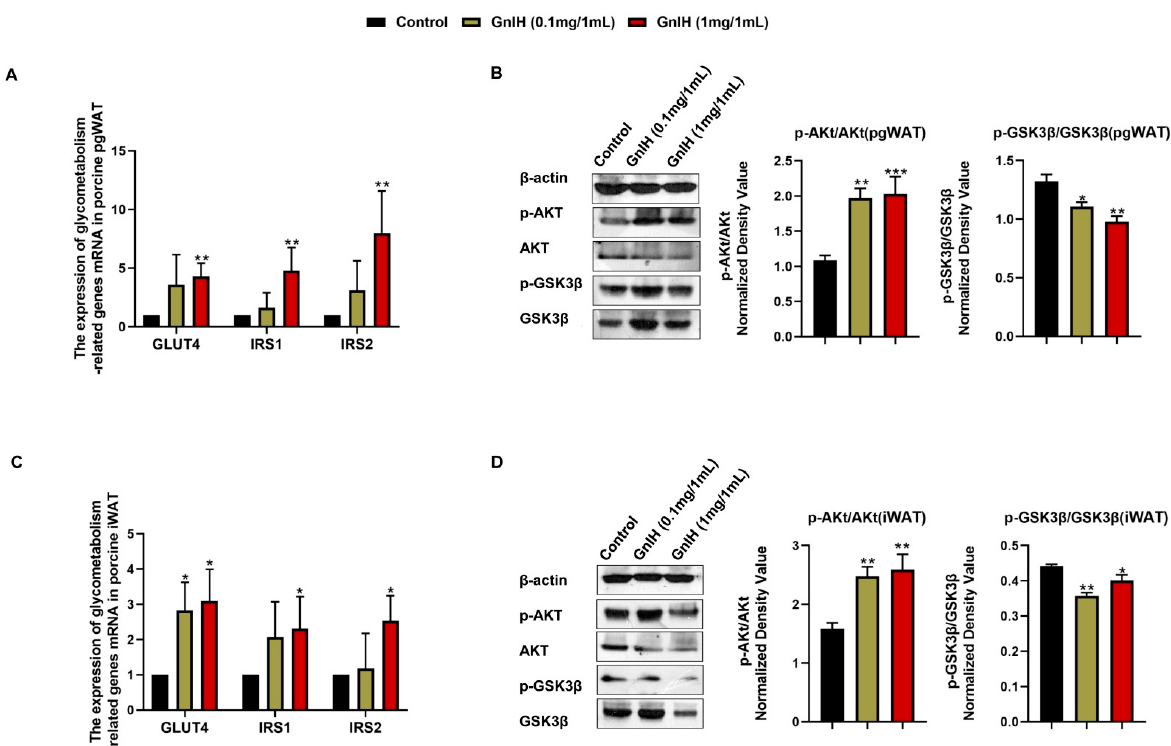
Figure 5. The mRNA expression levels of insulin resistance-related genes in pgWAT ( A ) and iWAT ( C ) of piglets administered different chronic doses of GnIH or vehicle for 14 days. Effect of intraperitoneally injected GnIH on AKT ‐ GSK ‐ related signaling in pgWAT ( B ) and iWAT ( D ) of piglets administered different chronic doses of GnIH or vehicle for 14 days. Densitometric quantification of p ‐ AKT and p ‐ GSK ‐ 3 β levels was performed after normalization to total AKT and GSK ‐ 3 β levels as loading controls. n = 3 independent experiments. pgWAT, perigonadal white adipose tissue; iWAT, inguinal white adipose tissue. The data are shown as the means ± SEM. * p < 0.05, ** p < 0.01 and *** p < 0.001 GnIH vs. vehicle. 2.7. Effect of Intraperitoneally Injected GnIH on the Expression Levels of Hepatic Lipid Metabolism ‐ Related Genes To reveal the molecular mechanism underlying the GnIH ‐ induced liver mass increase and hyperlipidemia after the chronic GnIH injections in piglets, we subsequently examined the mRNA expression levels of lipid metabolism ‐ related genes in the liver. As shown in Figure 6A, a high dose of GnIH induced a notable increase in the ACC (acetyl ‐ CoA carboxylase) and FABP4 (fatty acid binding protein 4) mRNA expression levels ( p < 0.05). On the contrary, GnIH markedly decreased ( p < 0.05 and p < 0.01) the expression levels of CPT ‐ 1 (carnitine acyltransferase I), AMPK α 1 (AMP ‐ activated protein kinase α 1), LXR α (liver X receptors α ) and ATP ‐ 5B (ATP synthase 5B) in a dose ‐ dependent manner. Simultaneously, no significant difference was observed in the expression levels of FASN (fatty acid synthase) and ACLY (ATP citrate lyase) after a GnIH injection compared with the vehicle ‐ treated piglets in the liver. To investigate whether the GnIH regulated the hepatic lipid metabolism via the active AMPK signal pathway, the effect of intraperitoneally injected GnIH on the hepatic AMPK signaling cascade was further evaluated. The results showed that the GnIH ‐ induced phosphorylation of AMPK α and AMPK β dramatically decreased ( p < 0.05, p < 0.01 and p < 0.001). In addition, the GnIH induced a significant increase in the protein expression levels of the C/EBP α (CCAAT ‐ enhancer binding protein α ) and the PPAR γ (peroxisome proliferator ‐ activated γ ) receptor ( p < 0.05 and p < 0.01) (Figure 6B).